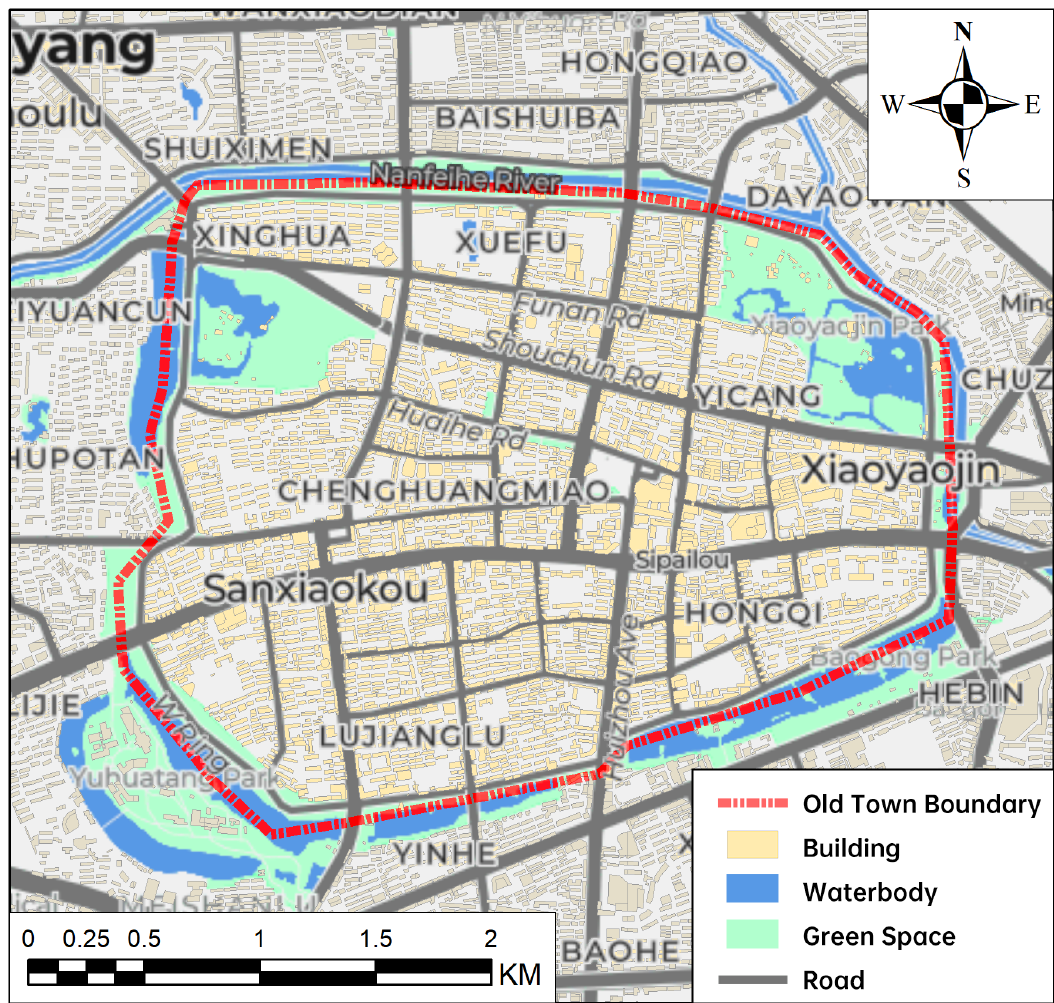
Figure 3. Map of Hefei Old Town (Data Source: Mapbox.com,